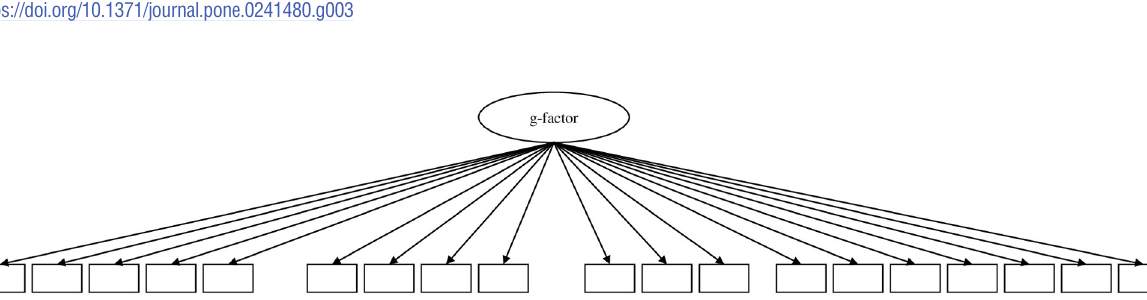
Fig 4. Hypothesized CFA model 4 of the MARS. Item-wise error variances are not represented in the models; correlations between errors were not allowed.